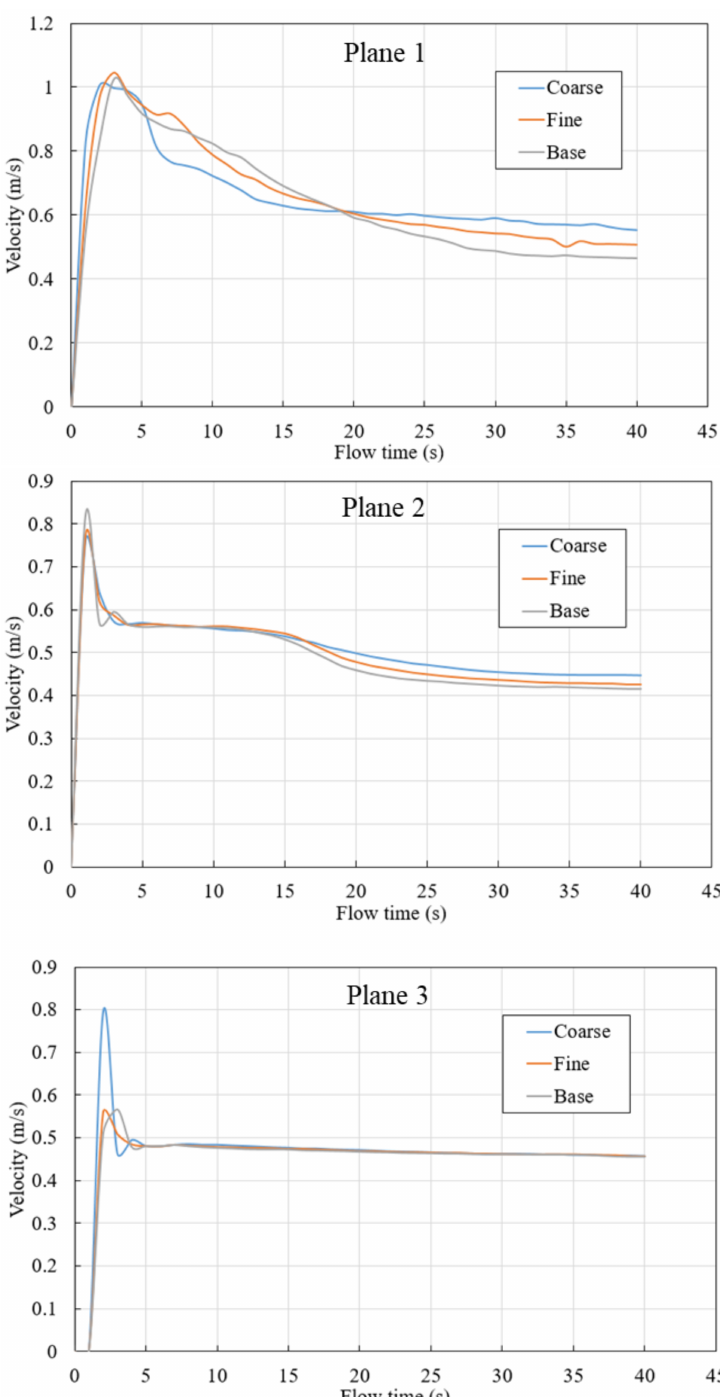
Figure 5. Average flow velocities for different